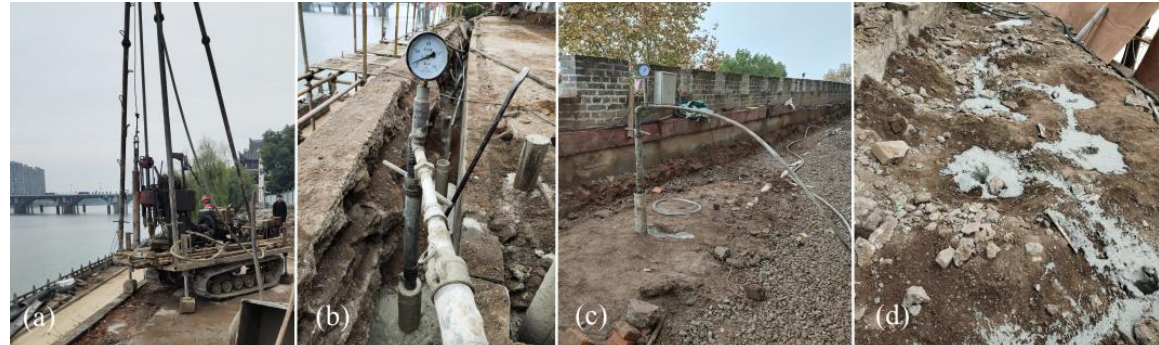
Figure 18. Modified lime grouting for filling of ancient riverbank. ( a ) Drill hole; ( b ) grouting pressure gauge; ( c ) modified lime grouting; ( d ) distribution of grouting holes.